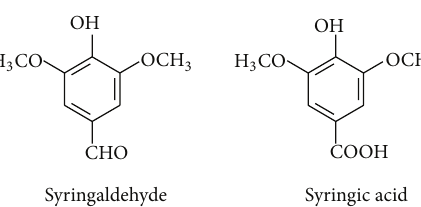
Figure 7: Structure of anti-inflammatory compounds isolated from edible